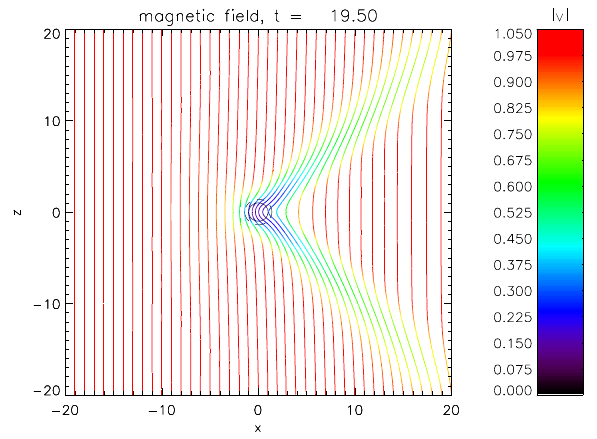
Fig. 2. Selected magnetic field lines in the ( u , B ) plane, with color denoting flow velocity in normalized units. The flow is incident from the left. Since sound speed and Alfv´en speed are both unity, the wings emanate in a tailward 45 ◦ wedge when viewed in the obstacle’s rest frame. The central circle marks the spherical volume inside of which deceleration according to Eq. (11) is